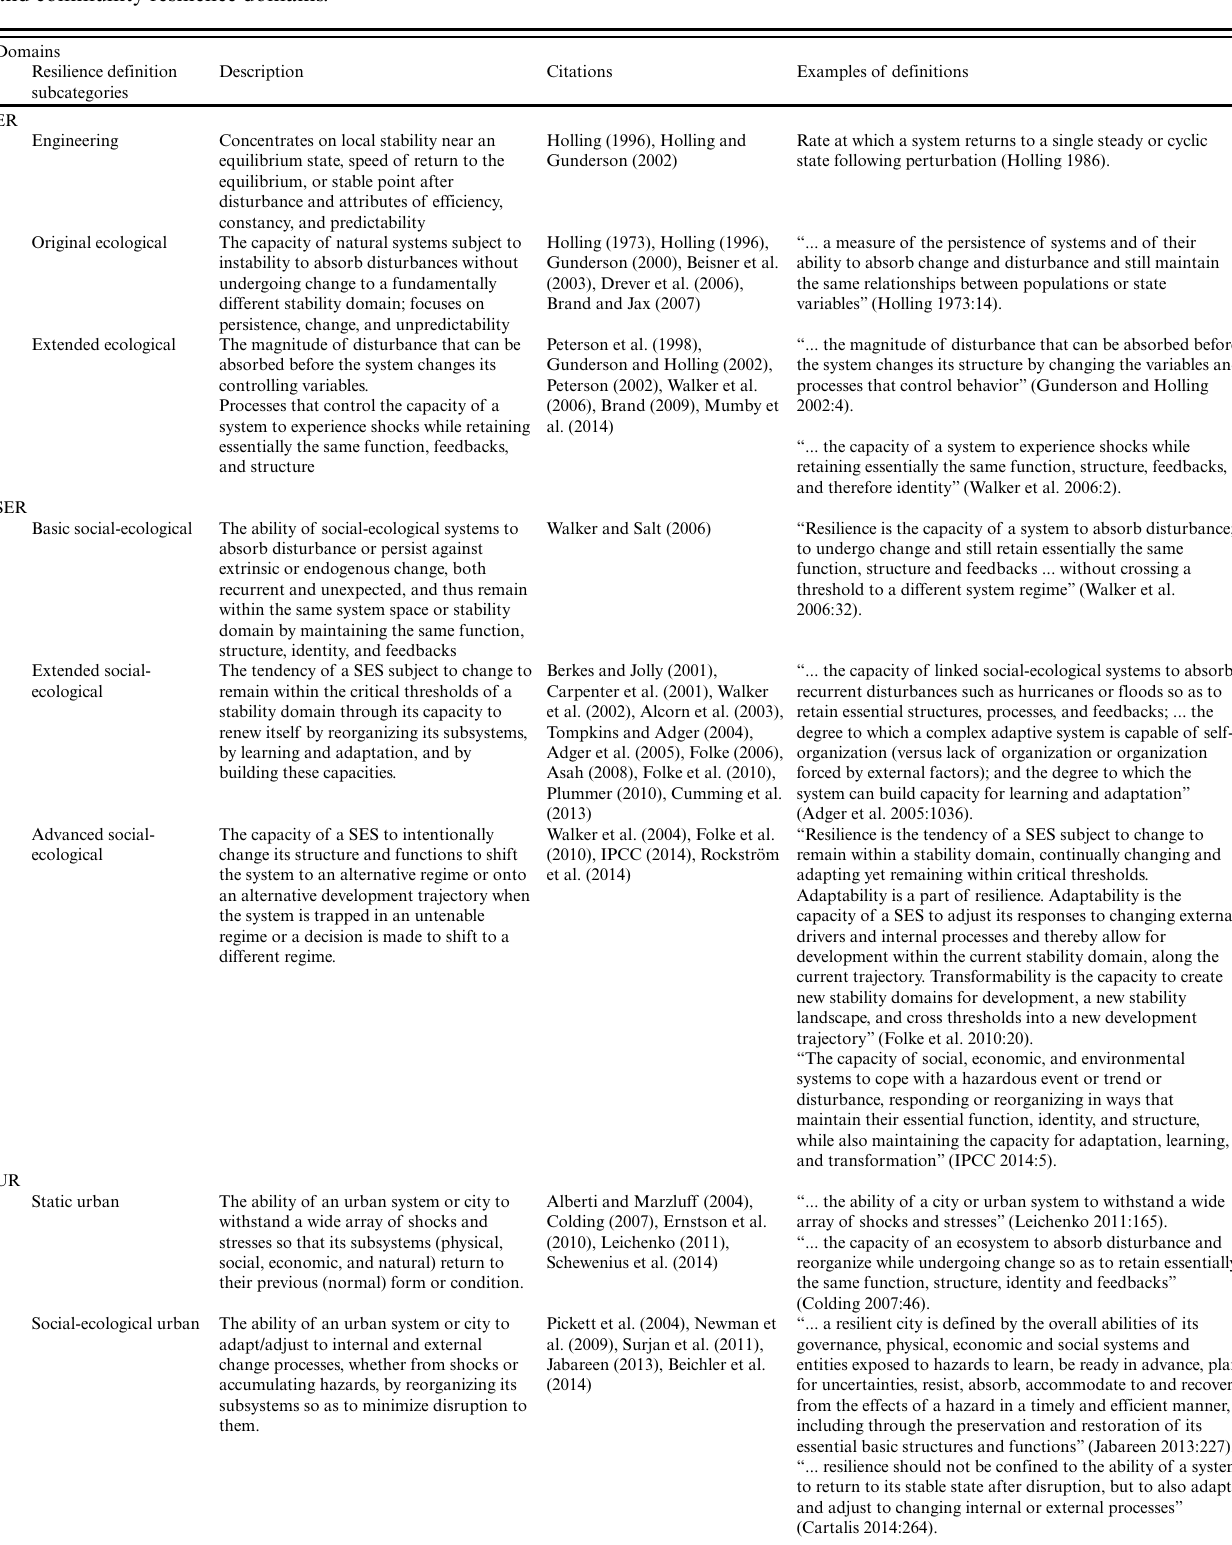
Table 1 . Classification of resilience definitions illustrating interpretational evolution in ecological, social-ecological, urban, disaster, and community resilience